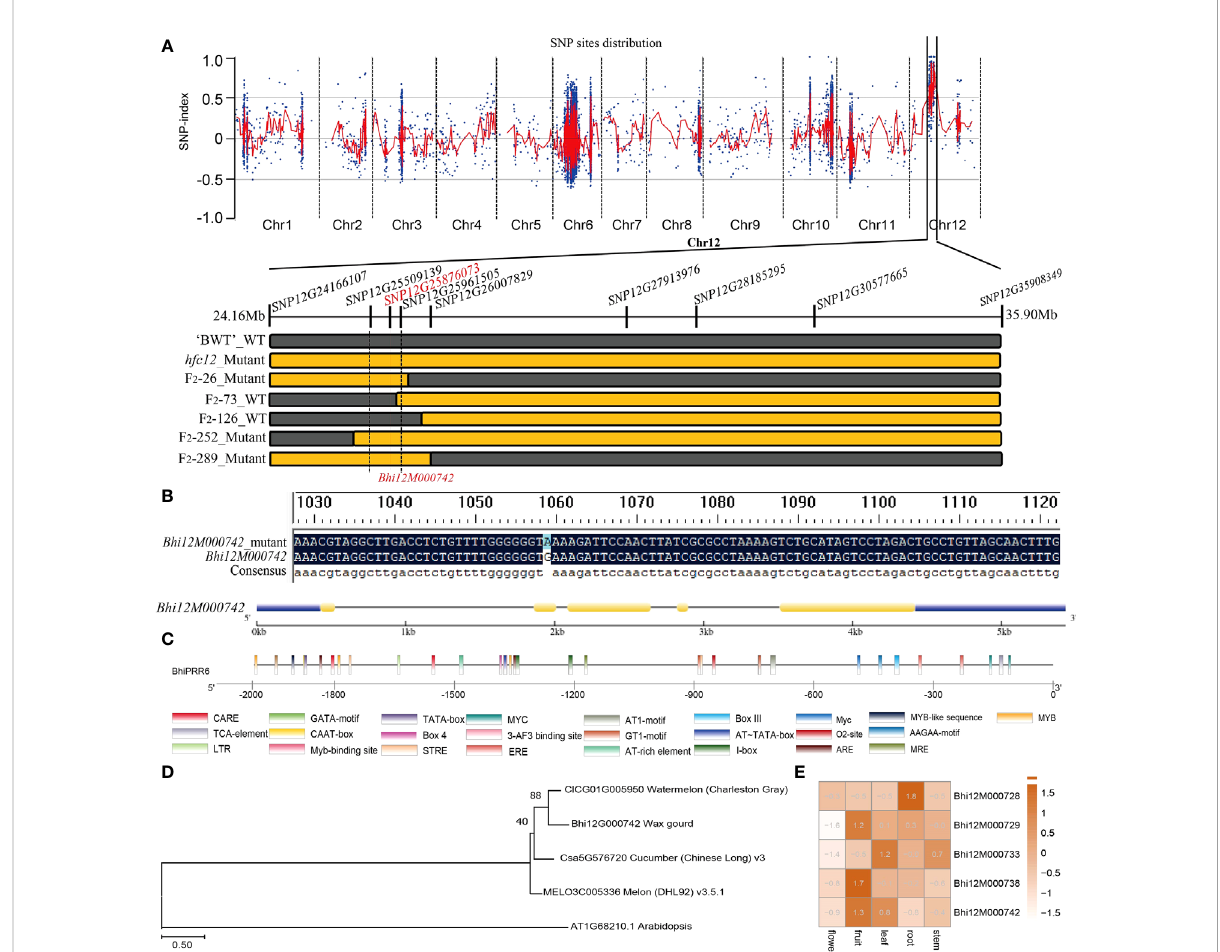
FIGURE 4 Cosegregation analysis and genetic variation in BhiPRR4 of wax gourd hfc12 . (A) Gene location and mutation site in wax gourd. BSA-seq generated the SNP distribution D (SNP index)] plot; the vertical axis represents the chromosome, and the red vertical line represents the location of the hfc12 SNP. The highest point shown is the locus 25 Mb to 30 Mb on chromosome 12. Based on F 2 plants with extreme phenotypes, the genetic map was drawn on the 452.366 kb region (SNP12G25509139 to SNP12G25961505 ). (B) Bhi12G000742 ( BhiPRR6 ) mutation of C to T in the SNP on the positive strand (G to A on the negative strand) of the second exon (red line). The yellow rectangle and the black line represent the exons and introns, respectively. (C) Schematic representation of BhiPRR6 promoter 2000 bp upstream of the CDS region. Cis -elements are shown in rectangles with different colors. (D) Multiple sequence alignment of BhiPRR6 proteins with watermelon, melon, cucumber, and Arabidopsis . (E) Different tissue expression levels of genes in the candidate